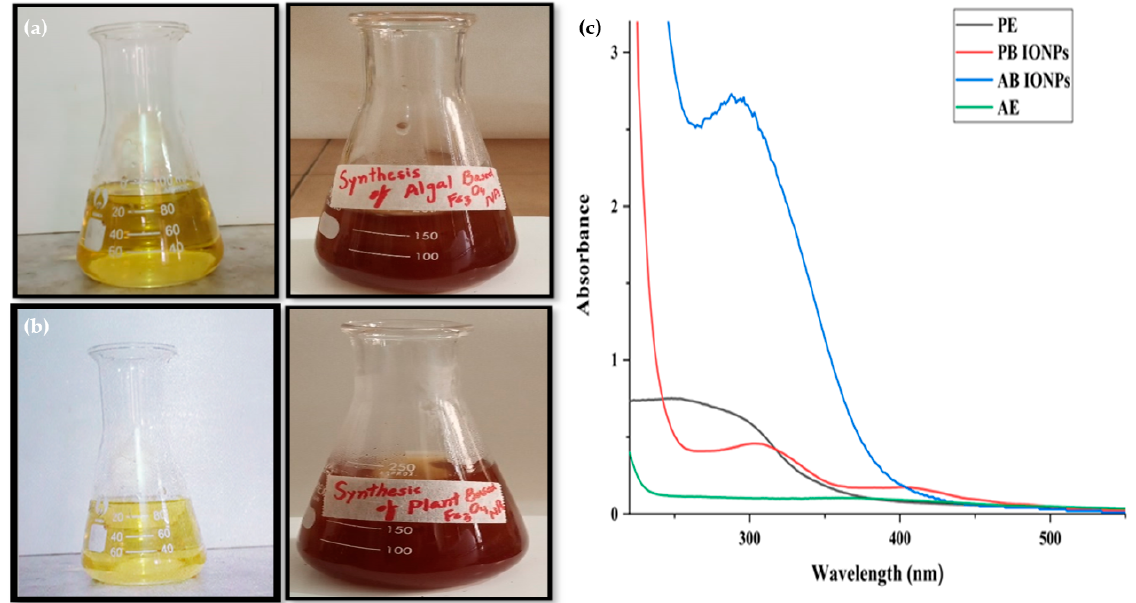
Figure 1. ( a ). A color change from the dark yellow of the algal extract to reddish-brown is observed during the biofabrication of algal-based IONPs. ( b ). The light yellow color of the plant extract changed into a dark brown during the biosynthesis of plant-based IONPs. ( c ). UV-Vis spectrum of algae extract, plant extract, and algal and plant-based Fe 3 O 4 NPs.